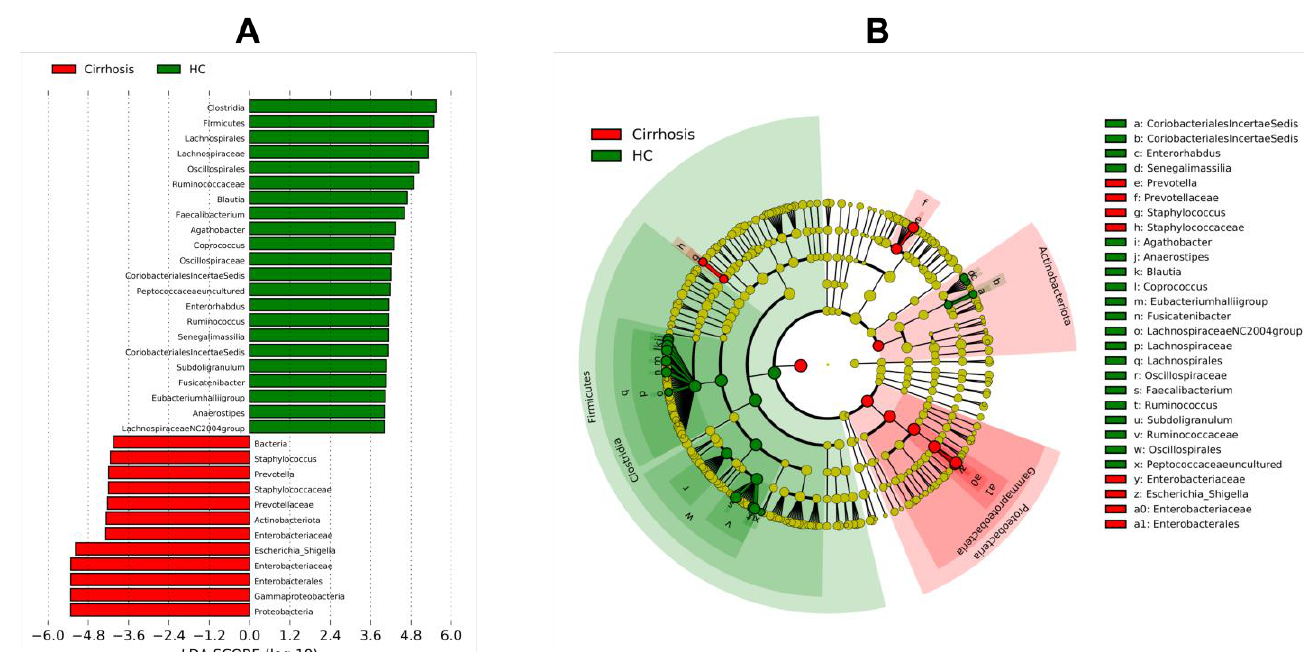
Figure 3. LEfSe analysis identifying key taxa in intestinal microbiota from patients with cirrhosis versus healthy control group (HC). ( A ) Bar plot showing LDA scores (Log > 4; p < 0.05); ( B ) Cladogram showing differentially abundant taxa at phylum, class, family, and genus levels between the two groups. Red circles indicate the remarkable taxa in the cirrhosis group while the green designates the HC group.